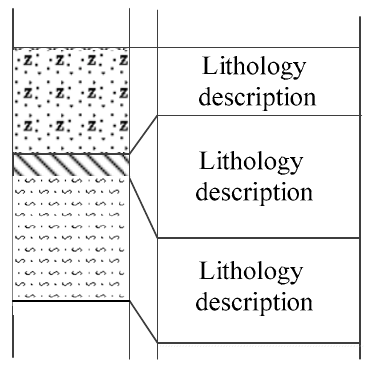
Figure 1. Excessive stratum description (beard phenomenon).